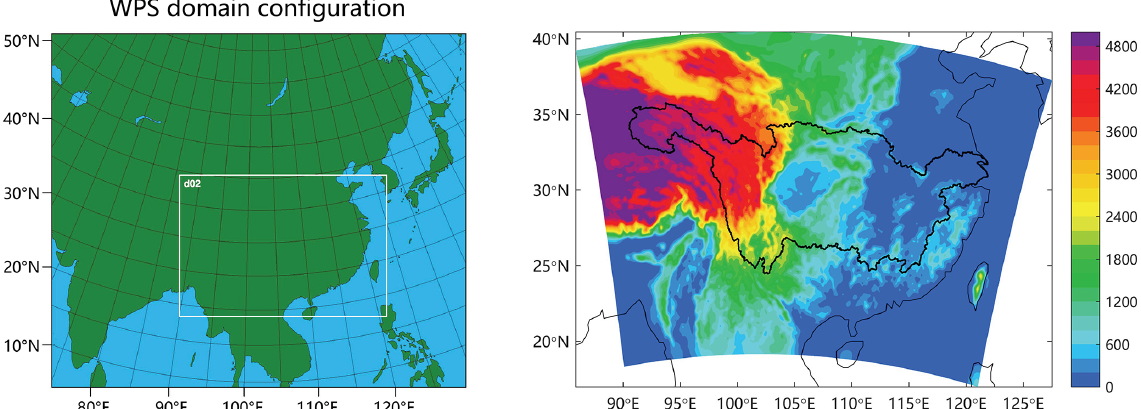
Figure 2. The WRF model domain and the model topography (units: